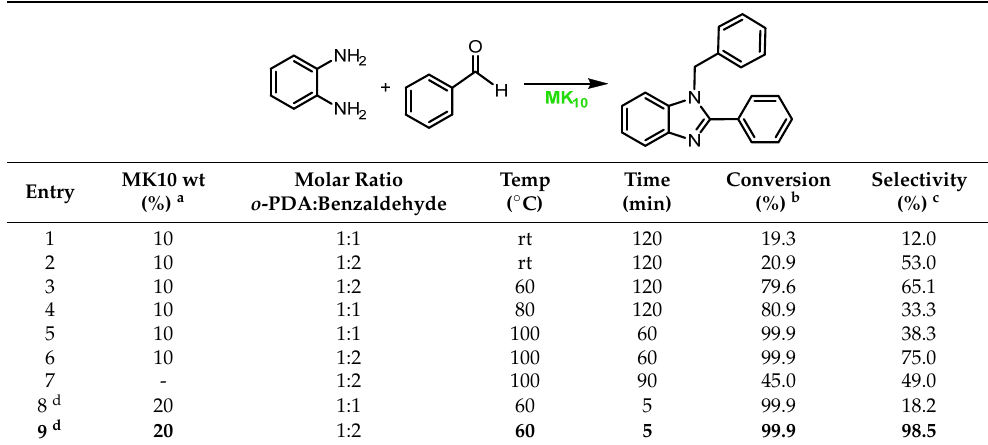
Table 1. Synthesis of benzimidazoles using MK10.